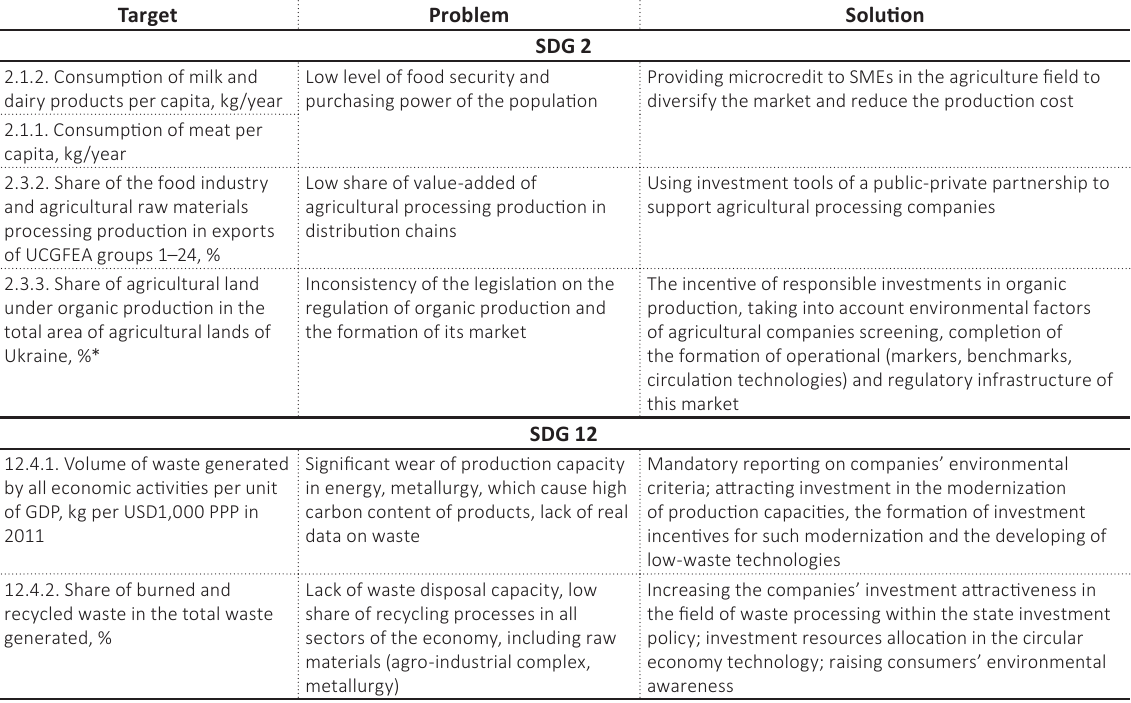
Table 5. Problems arising in the process of achieving SDGs 2 and 12 in Ukraine, and solutions to come up with them